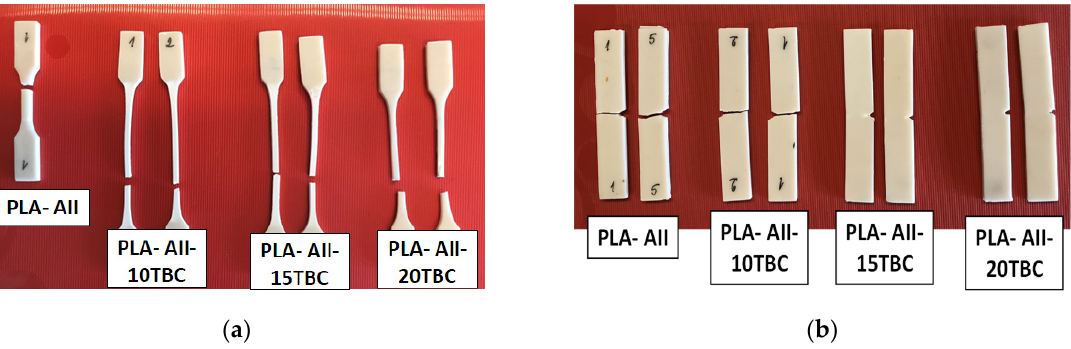
Figure 10. ( a , b ) Pictures of PLA/AII specimens (with/without plasticizer) to illustrate their aspect after the mechanical characterizations: ( a ) tensile and ( b ) Izod impact testing.